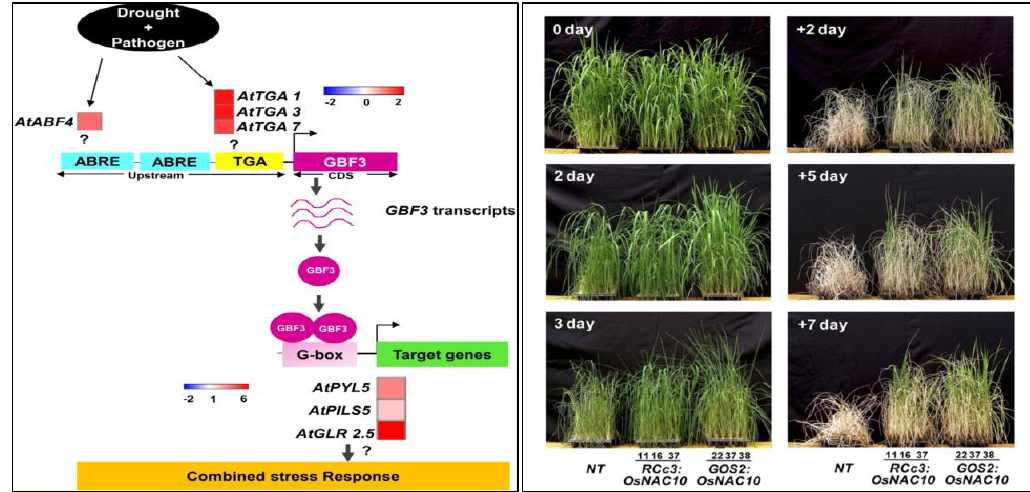
Figure 6. The regulatory mechanism of GBF3 in a combined drought and Pseudomonas syringae stress tolerance [105]. Root-Specific expression of OsNAC10 increased drought stress tolerance and grain yield in rice [96].